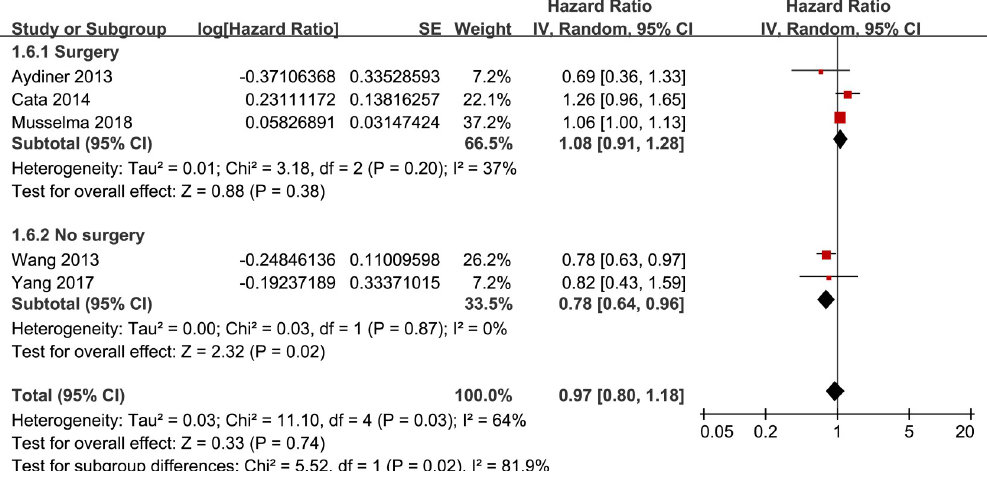
Fig 5. Stratified analyses for the meta-analysis of the association between BB use and OS of lung cancer according to whether surgical resection was performed.